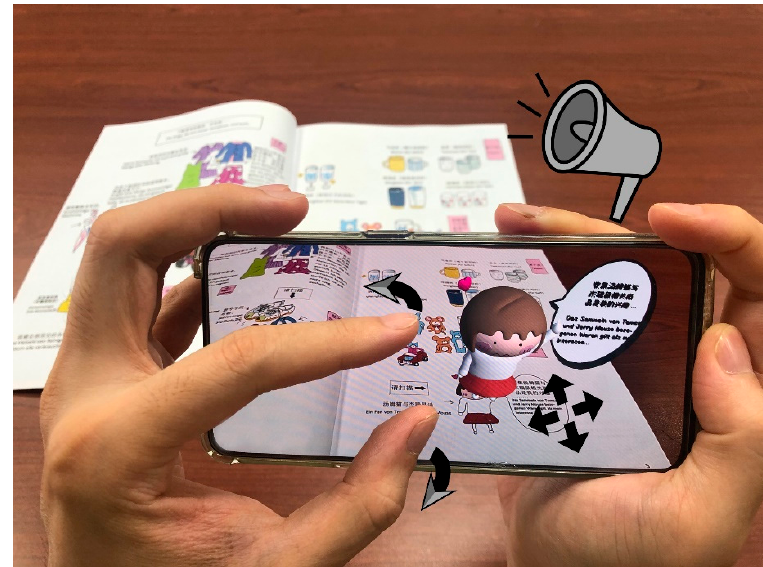
Figure 2. Bilingual AR picture book sample. Figure 3. Bilingual AR picture book